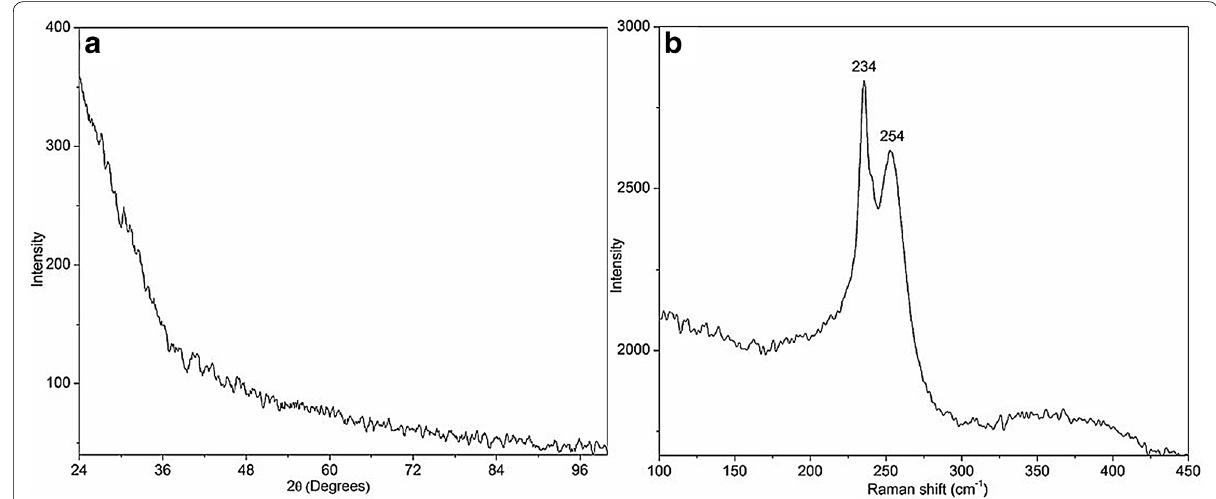
Fig. 5 a X-ray diffraction pattern and b Raman spectrum of selenium